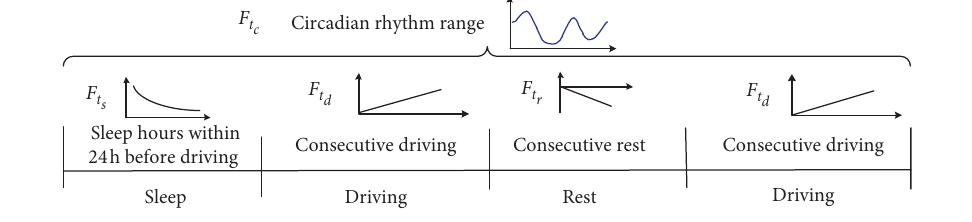
Figure 11: Time variable model description.